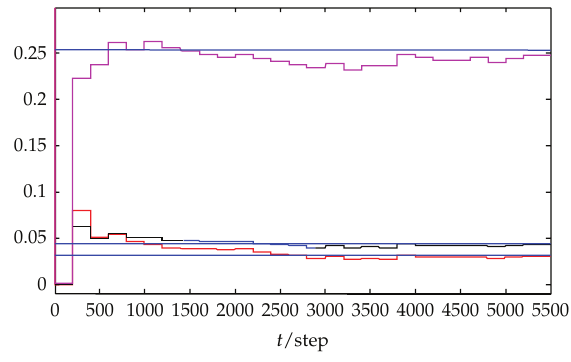
(cid:26)(cid:25) (cid:5) II (cid:6) (cid:5) t (cid:6) .